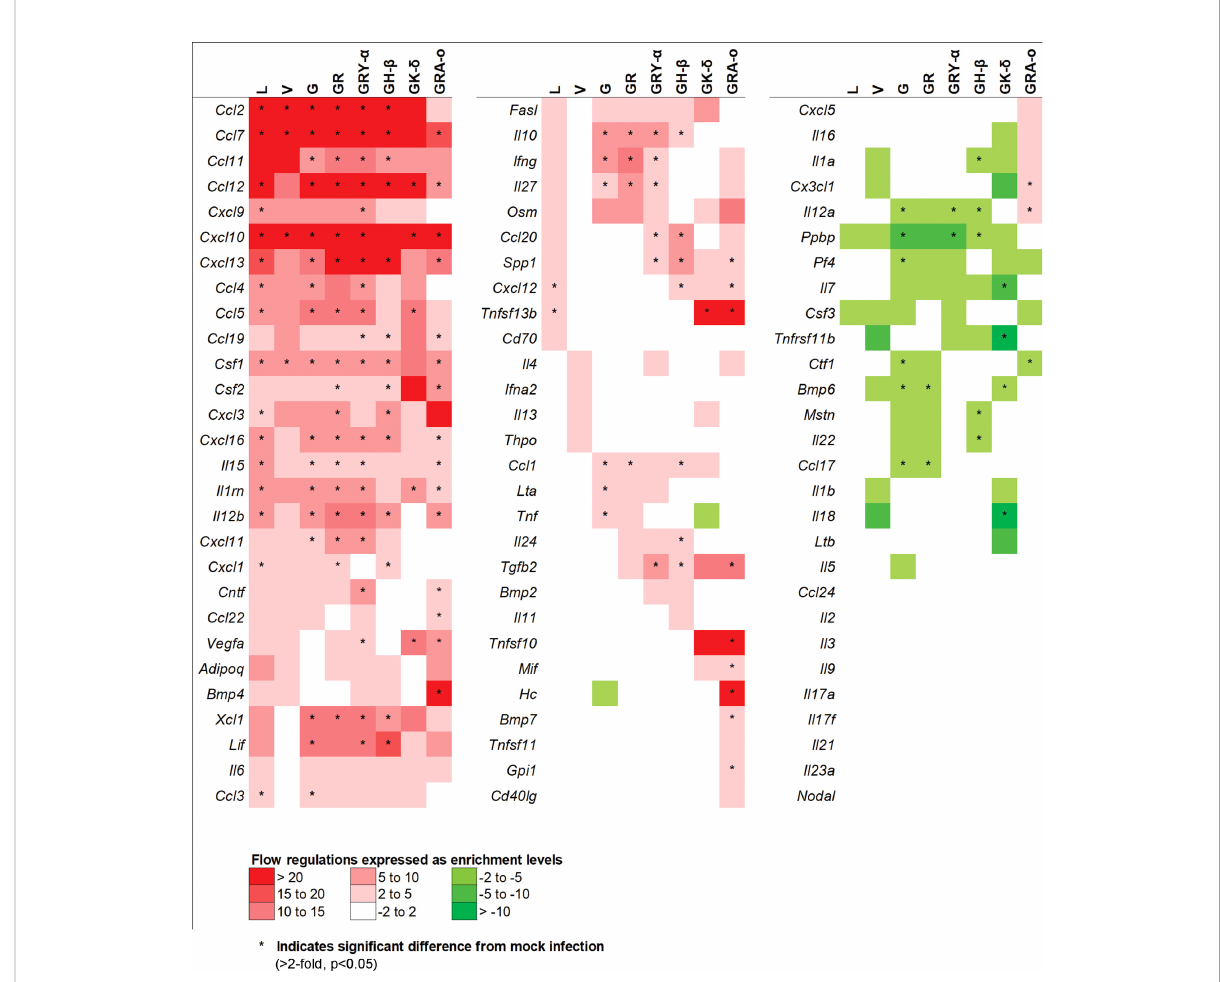
FIGURE 4 Comparison of 84 cytokines regulation changes among SARS-CoV-2 viruses at 4 dpi. Differentially regulated cytokines across all SARS-CoV-2 virus tested. Color scale indicating level of averaged fold-regulation changes across the groups, * indicate signi fi cant difference in fold- regulation changes (>2-fold, p<0.05) between infected and mock infected